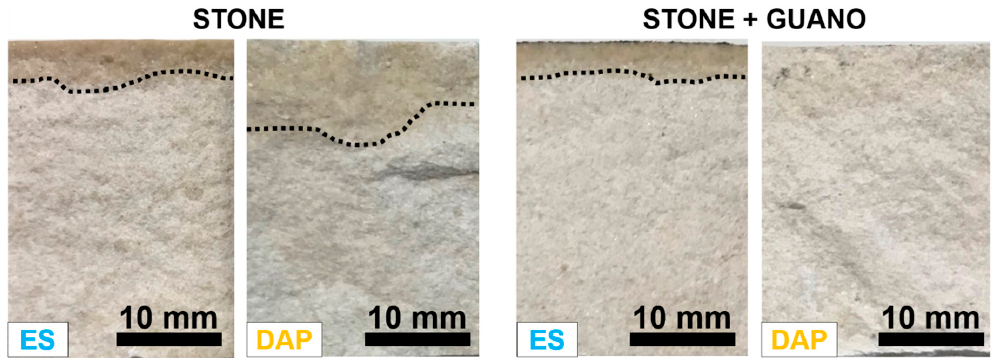
Figure 6. Examples of penetration depth of the treatments into the stone and stone+guano samples.